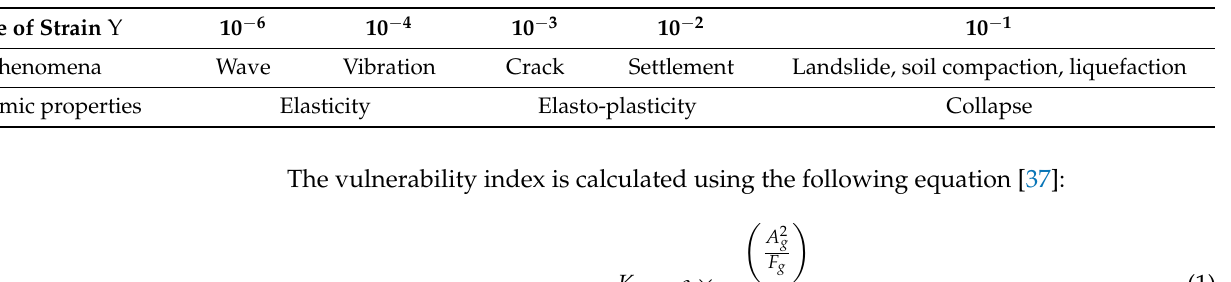
Table 1. Strain dependence of dynamic properties of the soil